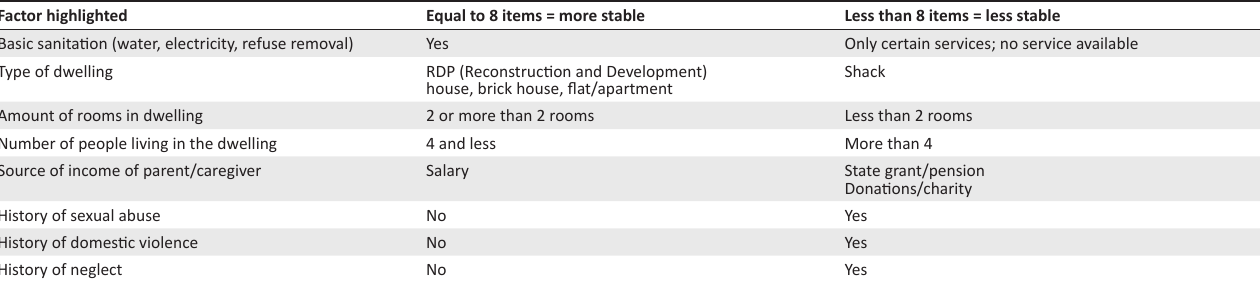
TABLE 1: Socioeconomic circumstances of family, neglect/abuse. Factor highlighted Equal to 8 items = more stable Less than 8 items = less